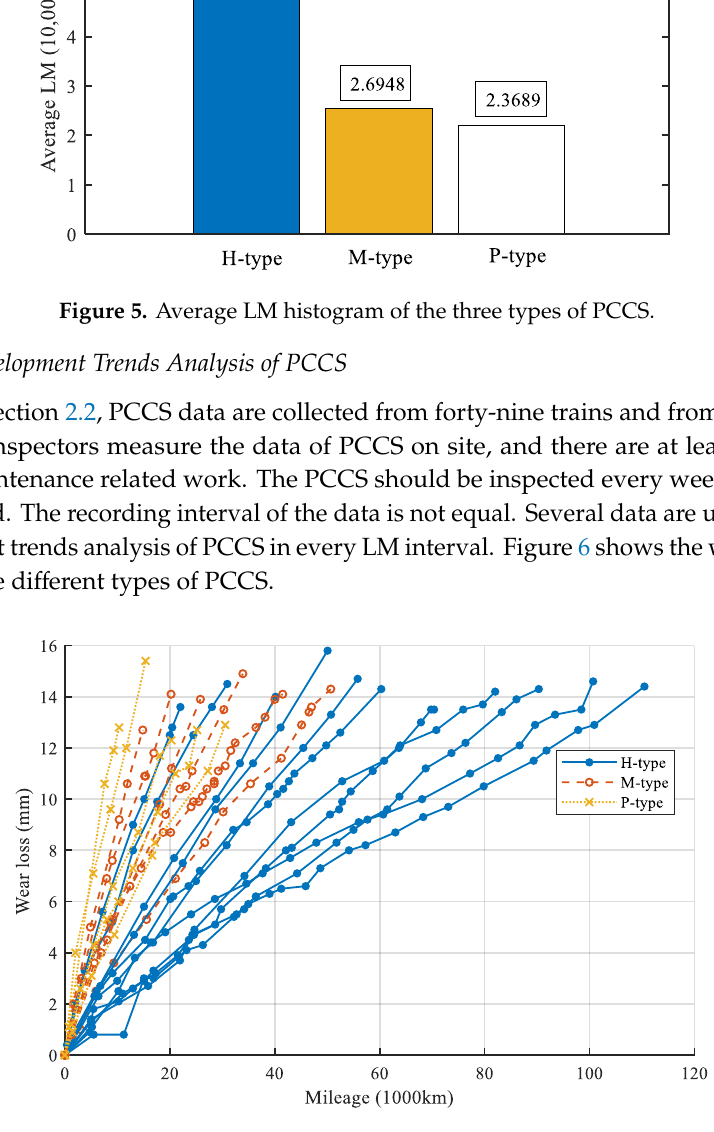
Figure 6. The wear trend of the three types of PCCS.